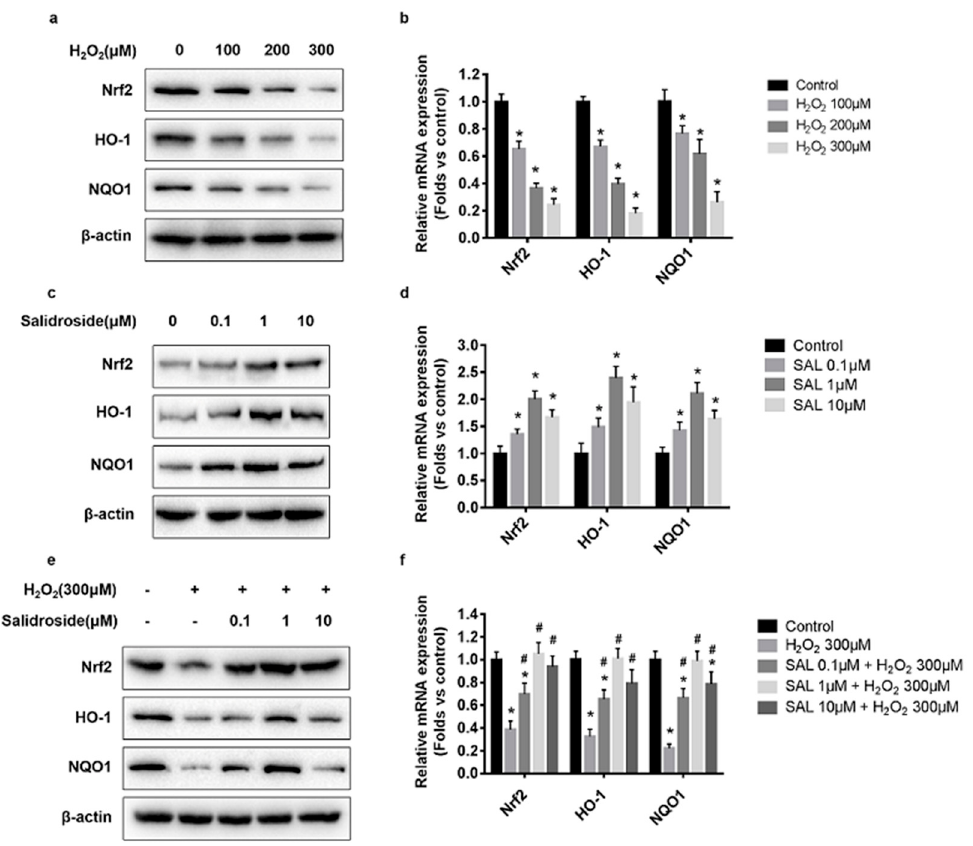
Figure 4. Effects of SAL and H 2 O 2 on protein and mRNA expression levels of Nrf2, HO-1, and NQO1 in HUVECs. ( a – b ) Expression of Nrf2, HO-1, and NQO1 in H 2 O 2 -treated HUVECs. HUVECs were incubated with H 2 O 2 (100–300 μ M) for 4 h, relative protein levels were measured using Western blotting, and relative mRNA levels were determined using RT-PCR. ( c – d ) Expression of Nrf2, HO-1, and NQO1 in SAL-treated HUVECs. HUVECs were incubated with SAL (0.1, 1, 10 μ M) for 24 h, and total cell lysates were subjected to Western blotting and RT-PCR. ( e – f ) Effects of SAL on Nrf2, HO-1, and NQO1 expression in H 2 O 2 -treated HUVECs. HUVECs were incubated with SAL (0.1, 1, 10 μ M) for 24 h, followed by 300 μ M H 2 O 2 for an additional 4 h, relative protein levels were measured using Western blotting, and relative mRNA levels were determined using RT-PCR. The results of RT-PCR were normalized to β -actin, and expressed as fold change to control. The values represent the means ± SD of triplicate experiments. * p < 0.05 vs. control. # p < 0.05 vs. H 2 O 2 -treated HUVECs.